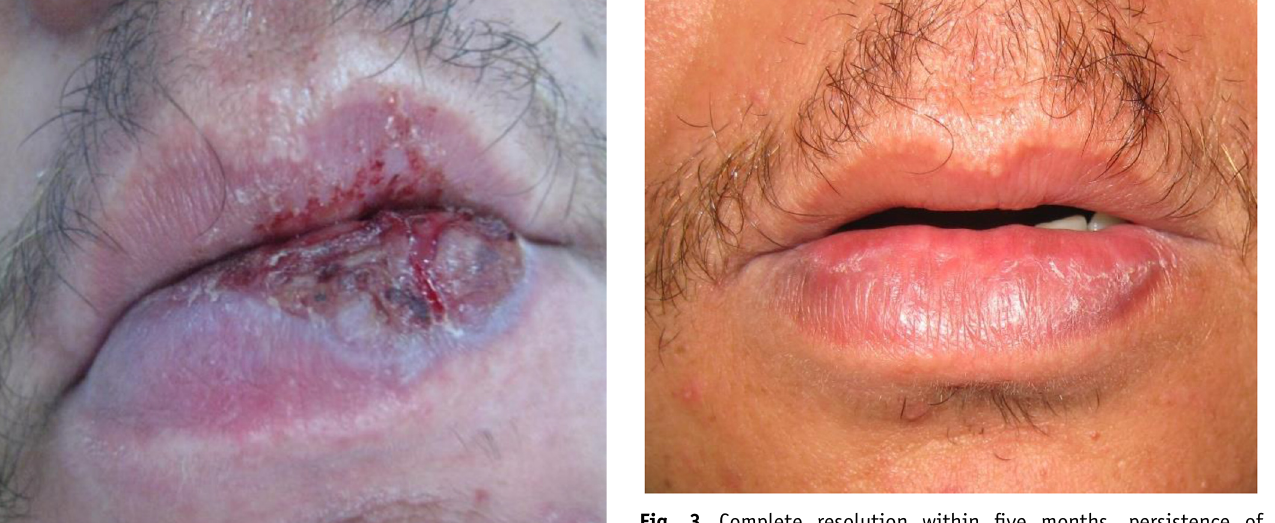
Fig. 3. Complete resolution within fi ve months, persistence of atrophic and reticular aspect of the lower lip.